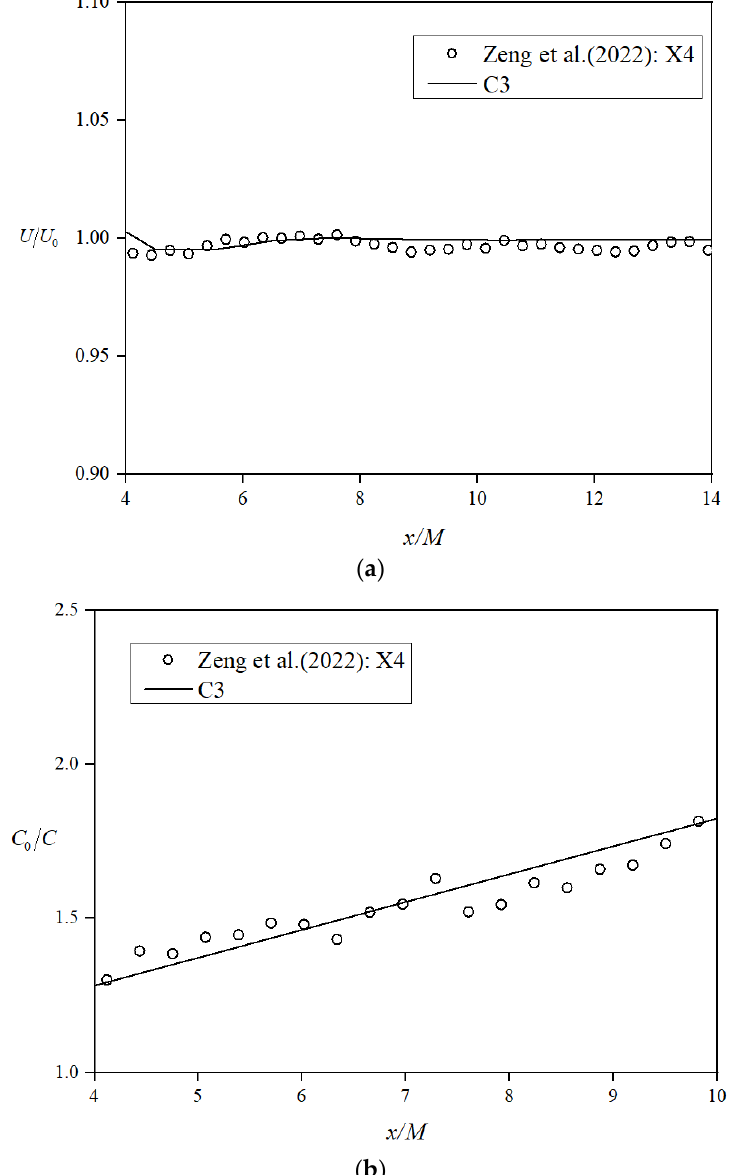
Figure 5. The comparison of the variation of ( a ) U/U 0 and ( b ) C 0 / C with longitudinal distance x/M along the flume centerline [8].